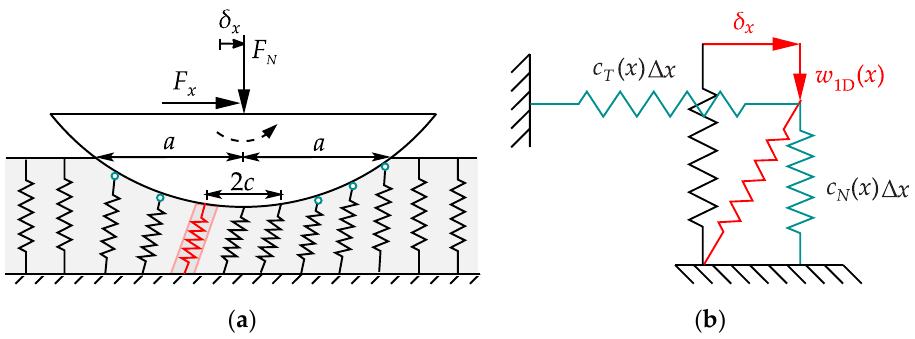
Figure 3. Equivalent 1D model for tangential contacts in the Abel transformed domain: ( a ) Rigid plane indenter subjected to a constant normal force and a monotonically increasing tangential force with stick and slip domain; ( b ) Detailed view of a spring in the stick region.